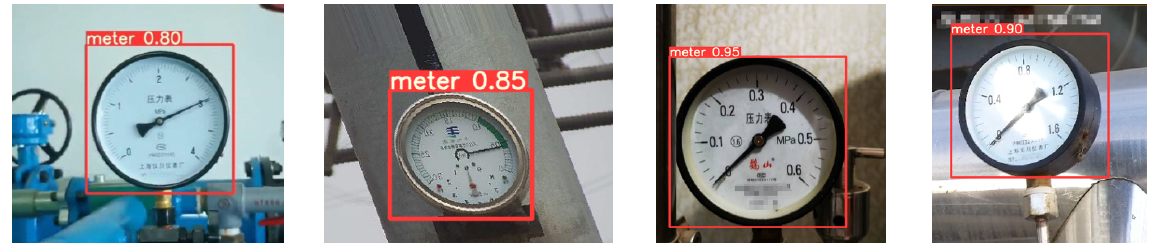
Figure 3. Detection results of pointer meter.